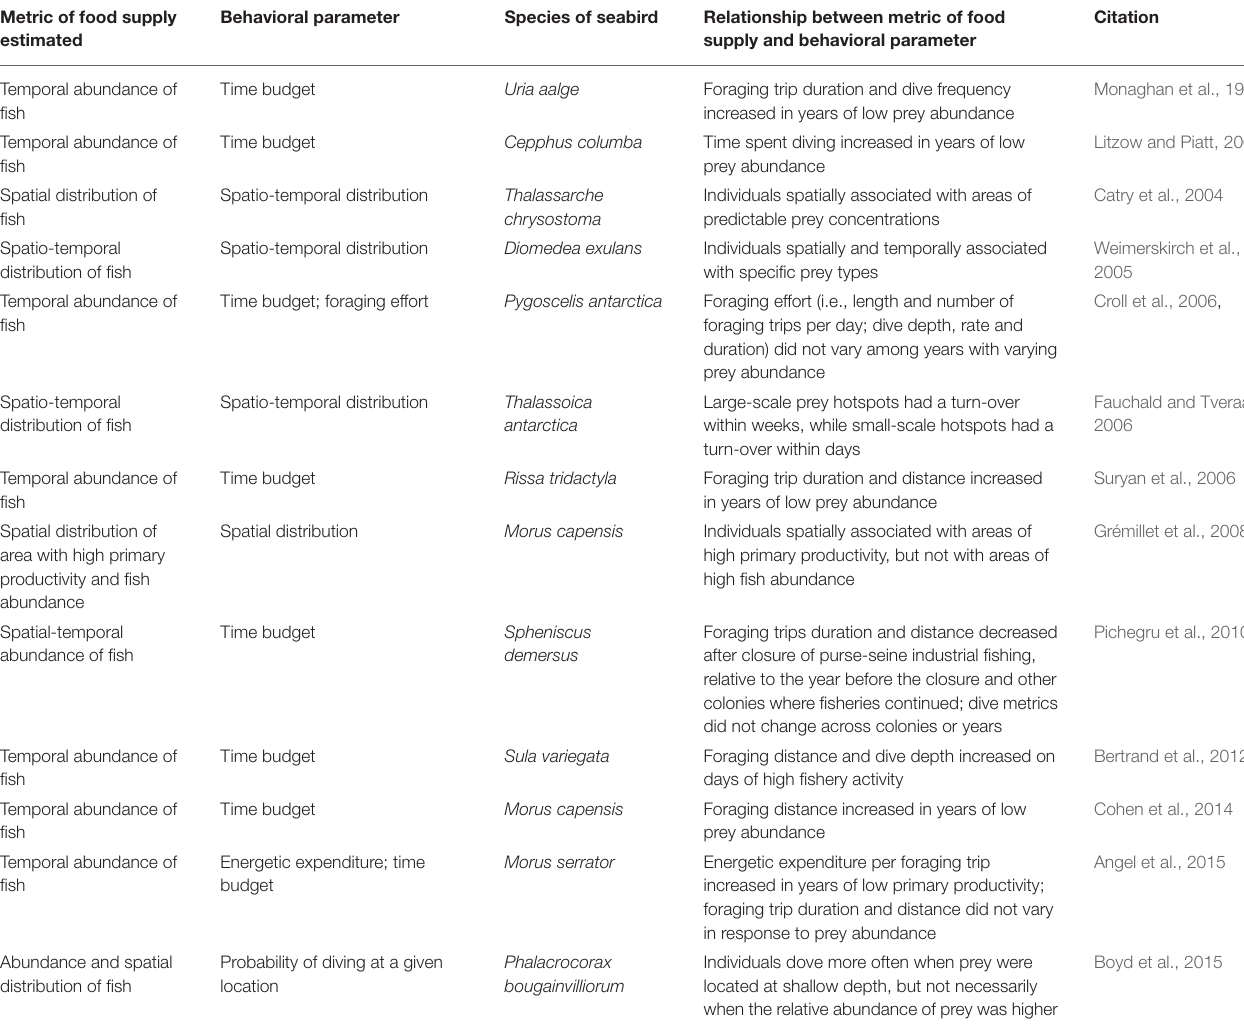
TABLE 1 | Studies that used biologgers to link seabird foraging parameters to food supply (variation in time, space, or